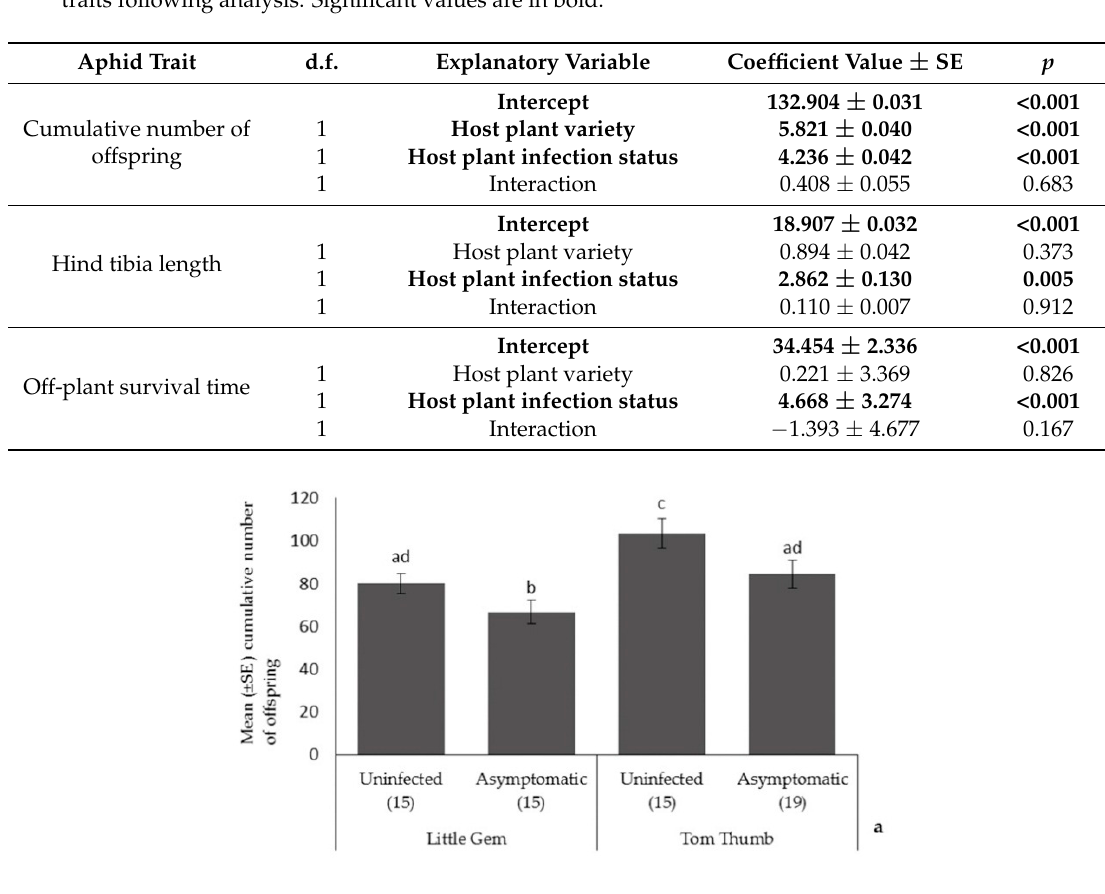
Table 3. Summary of effects of asymptomatic B. cinerea infection status and plant variety on aphid traits following analysis. Significant values are in bold.